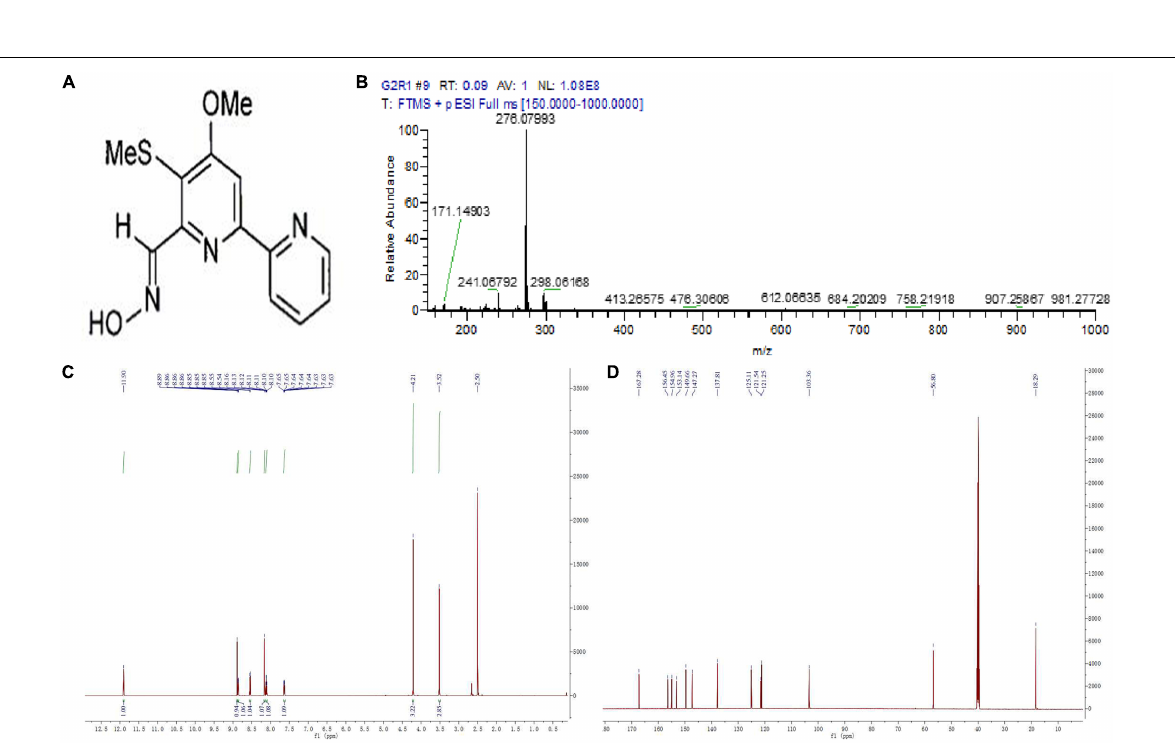
Frontiers in Microbiology |